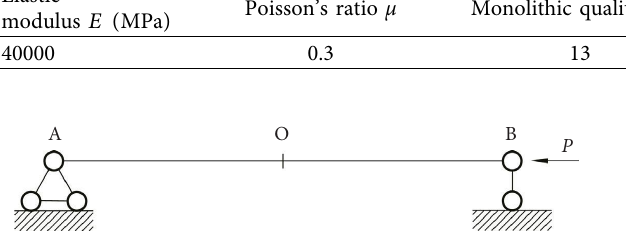
Figure 6: Te buckling analysis model of composite